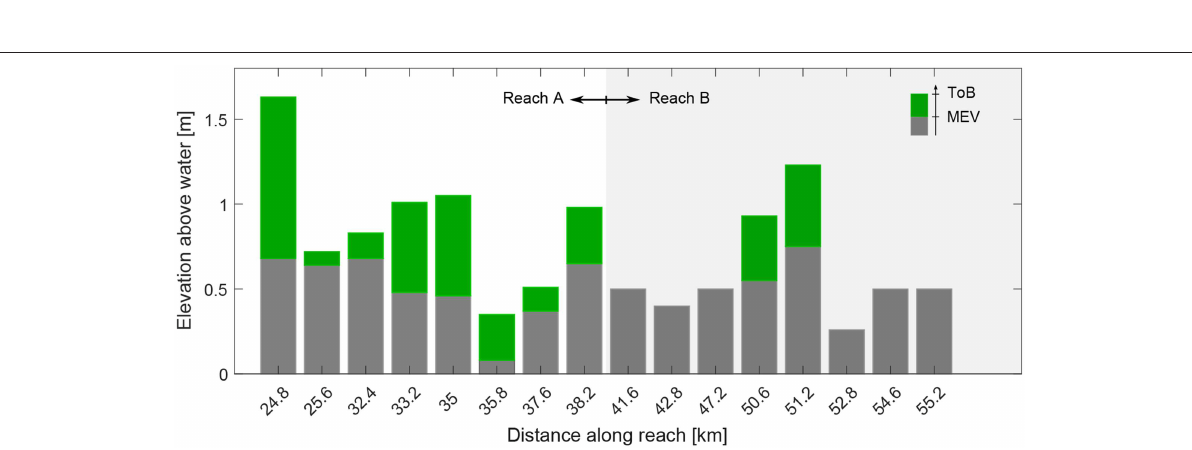
FIGURE 9 | Minimum elevation at which vegetation was observed in 2008 (MEV) and top bar elevation (ToB). These values were calculated along the cross sections and for the selection of bars given in Table 2 . Elevations are reported with respect to the average water level of the day when the image was taken in 2008.